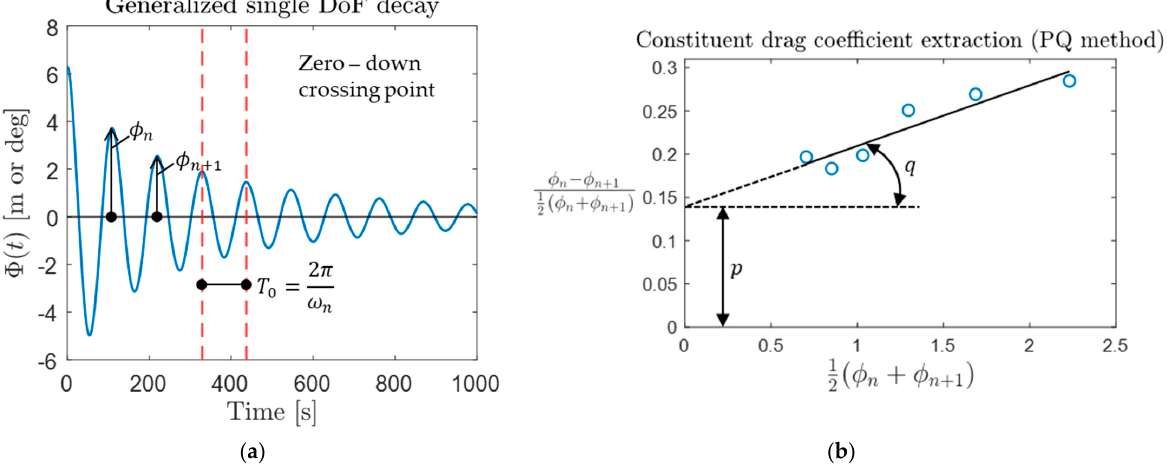
Figure 3. PQ method constituent coefficient extraction using least square curve fit of the crest amplitudes: ( a ) free decay test showing the wave crest amplitudes; ( b ) straight line curve by least square method to obtain the constituent coefficients ‘p’ and ‘q’.